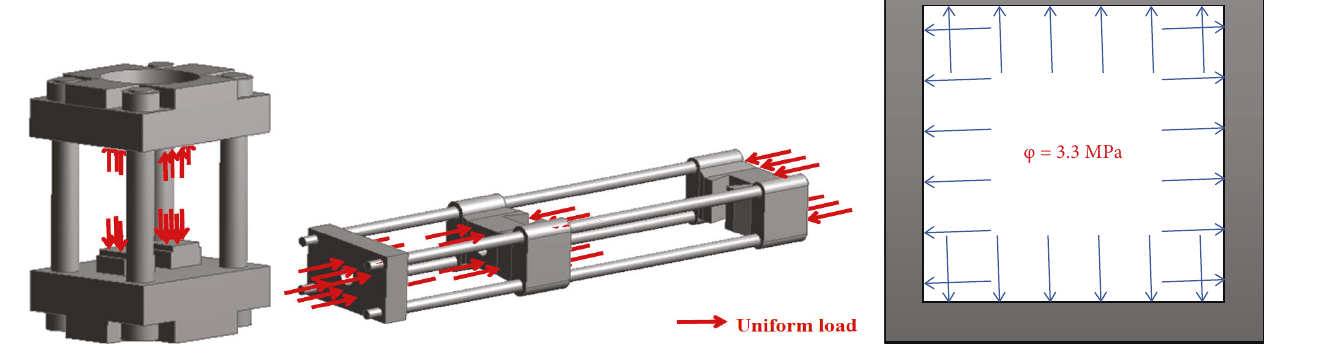
Figure 7: Schematic diagram of the main structure under